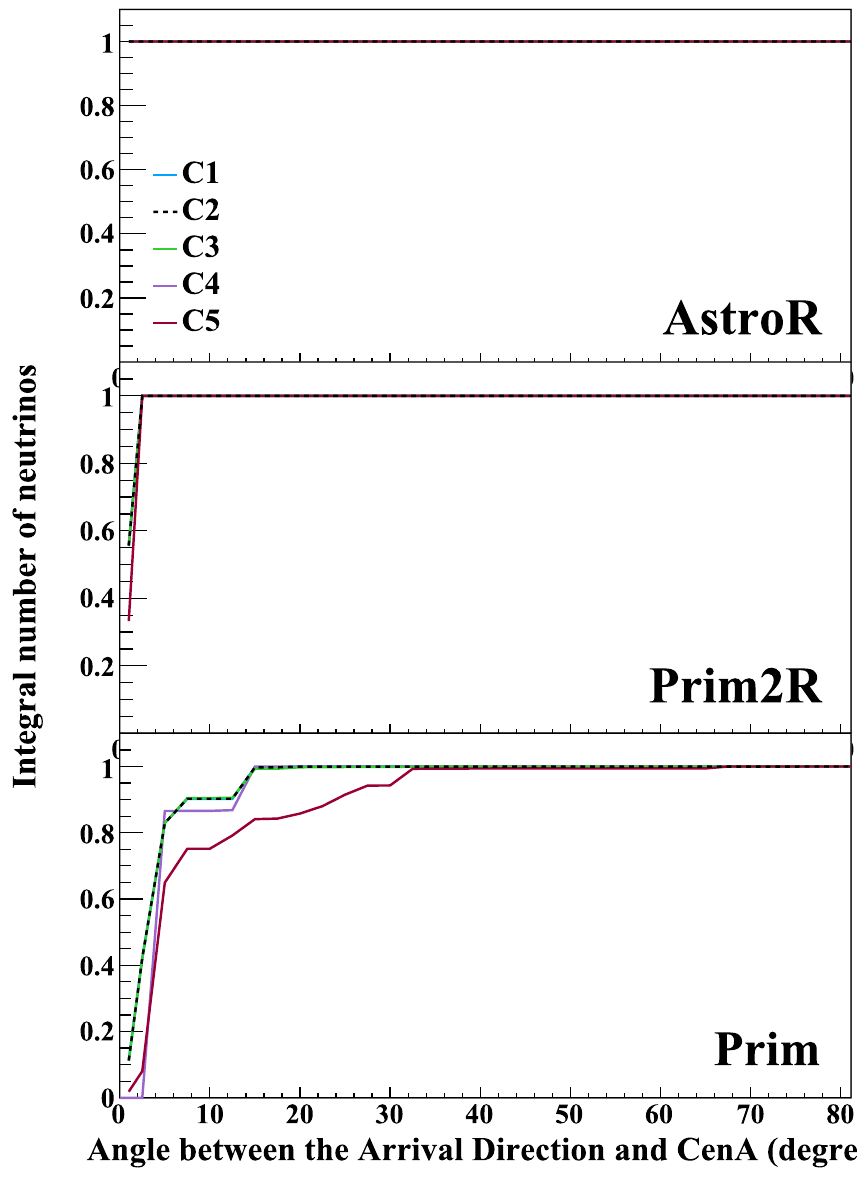
Fig. 6 Integral distribution of the angular distance between Cen A and the arrival direction of secondary neutrinos. Three EGMF are shown: AstroR, Prim2R and Prim. Each curve corresponds to a composition abundance: